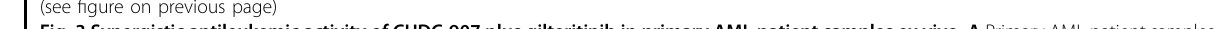
Fig. 3 Synergistic antileukemic activity of CUDC-907 plus gilteritinib in primary AML patient samples ex vivo. A Primary AML patient samples (FLT3-ITD positive) were treated with gilteritinib, CUDC-907, both, or neither, for 24 h concurrently, and then annexin V/PI staining and fl ow cytometry analysis was performed. CI values were calculated using CompuSyn software. Individual CI values are shown in Supplementary Table S5. B Three primary patient samples (FLT3-ITD positive) were treated with gilteritinib and/or CUDC-907 for 24 h and then whole-cell lysates were subjected to western blot analysis of cleaved-caspase 3 (cf-caspase 3) and β -actin. C , D Six FLT3-wt AML patient samples (panel C ) and two samples of normal peripheral blood mononuclear cells (panel D ) were treated with gilteritinib, CUDC-907, both, or neither, for 24 h concurrently, and then annexin V/PI staining and fl ow cytometry analysis were performed. CI values were calculated using CompuSyn software. Individual CI values are shown in Supplementary Table S6. * p < 0.05, ** p < 0.01, and *** p < 0.001 compared to single-drug treatments. E , F Primary AML patient samples (panel E ) and normal human umbilical cord blood cells (panel F ) were treated with gilteritinib, CUDC-907, both, or vehicle control for 24 h concurrently, and then plated in methylcellulose. The number of leukemic colonies (AML-CFUs), erythroid, and myeloid colonies were counted 10 – 14 days later. Data are presented as mean ± SEM. * p < 0.05, ** p < 0.0,1 and *** p < 0.001 compared to control. # p < 0.05 and ### p < 001 compared to single-drug treatments. Technical triplicates were